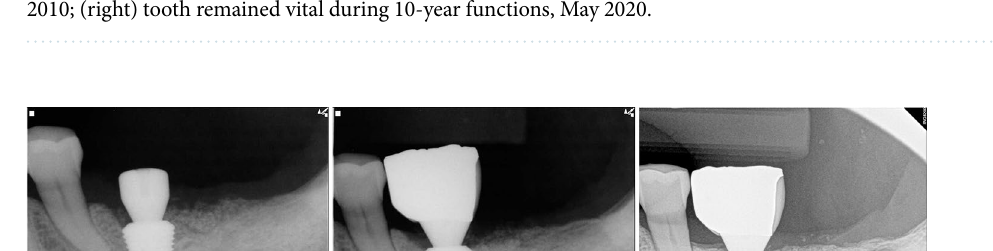
Figure 3. Root surface contact (Group II); (left) At the time of implant surgery, July 2010; (center) December 2010; (right) tooth remained vital during 10-year functions, May 2020.